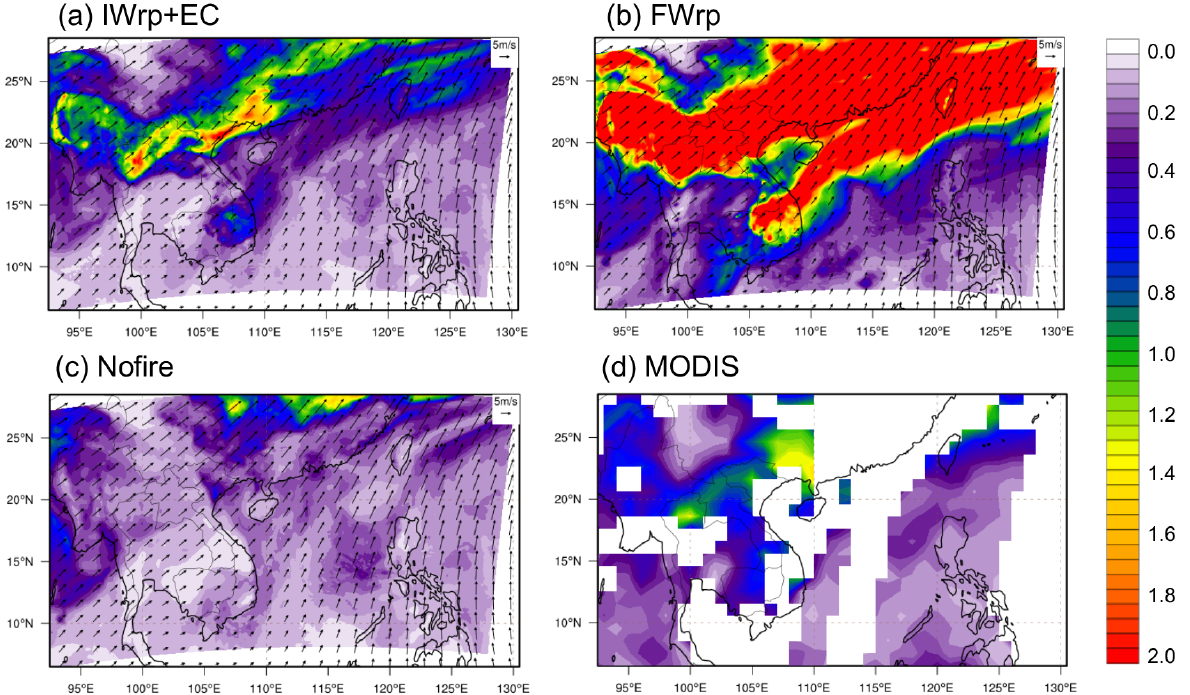
Figure 7. Comparison of daily total column AOD on 20 March (10:30LST) of model output (a) IWrp + EC, (b) FWrp and (c) nofire with (d) MODIS data from Fig. 5. Vector profiles given in (a–c) are the surface wind